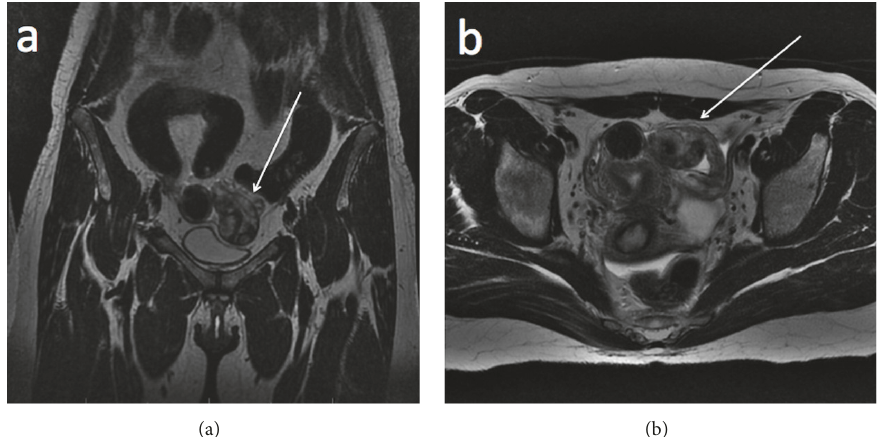
Figure 2: (a) T1-weighted coronal and (b) axial pelvic magnetic resonance imaging showing a cystic-solid lesion originating from the left fallopian tube (white arrow).